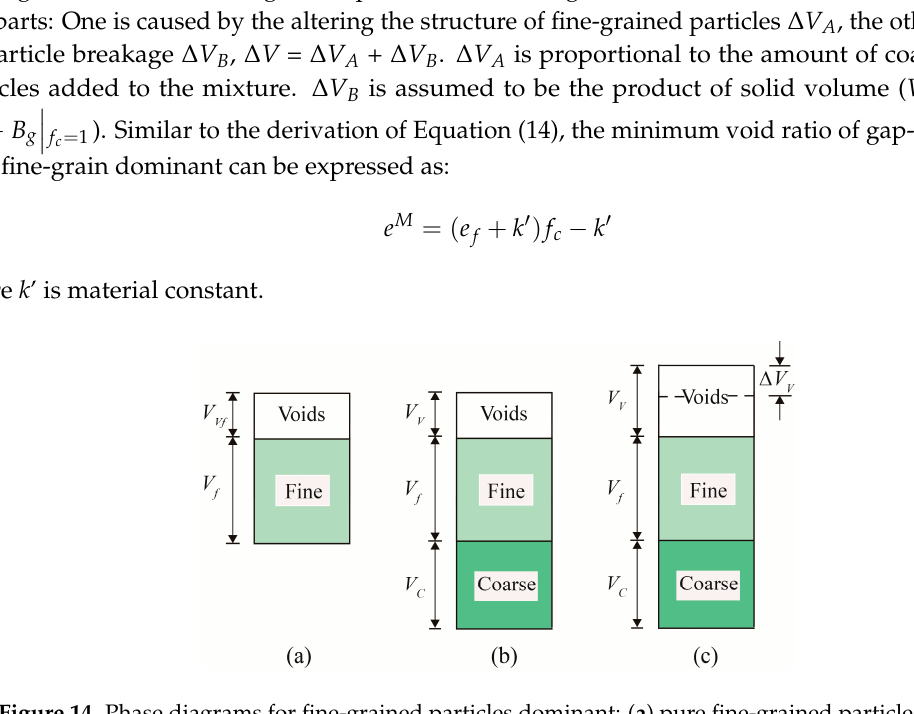
Figure 14. Phase diagrams for fine-grained particles dominant: ( a ) pure fine-grained particles (before coarse-grained particles added), ( b ) mixture (limiting case), ( c ) mixture (general case).